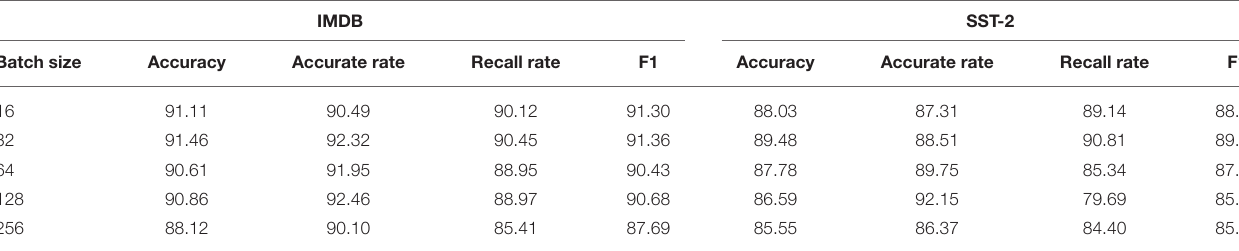
TABLE 6 | Experimental results of different batch_size values. IMDB SST-2 Batch